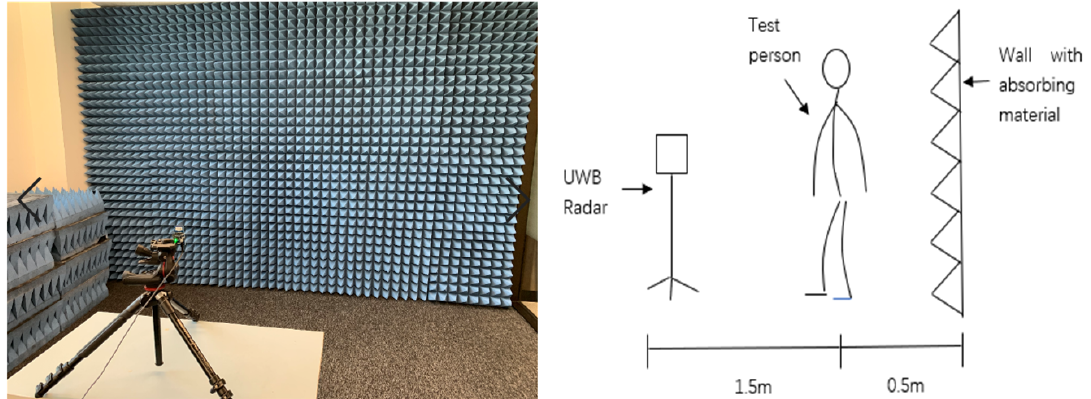
Figure 5. Schematic diagram of radar setting in the experimental environment.